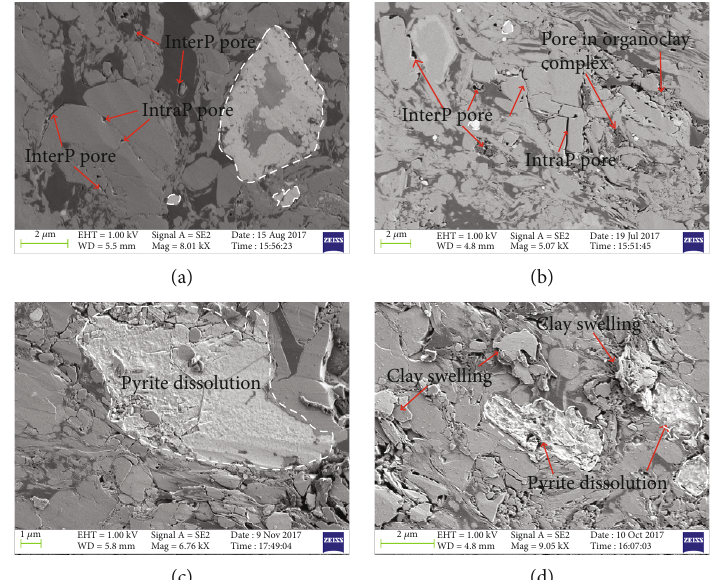
Figure 3: Field emission scanning electron microscope (FE-SEM) images of raw (a, b) and treated (c, d) YY shale (the white marks are the pyrite